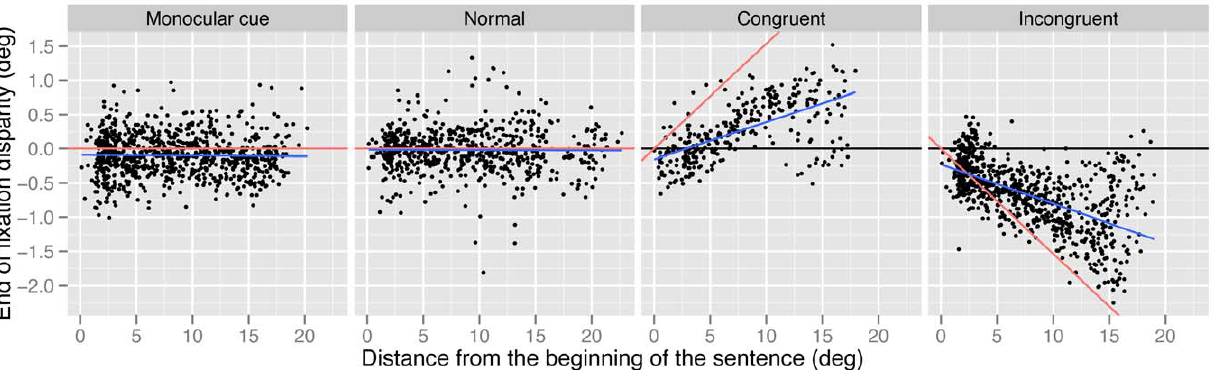
Figure 3. Disparity at the end of fixations, as the reader progresses through the sentence across the different experimental conditions. Positive values denote crossed fixations (i.e., the eyes are aligned in front of the plane of the screen) and negative values denote uncrossed fixations (i.e., the eyes are aligned behind the plane of the screen). Black lines (set at 0 u ) represent the plane of the display screen; blue lines indicate the effect of distance from the beginning of the sentence on fixation disparity; red lines indicate the disparity that would be produced if subjects were to fuse the sentence as it appeared in virtual depth.